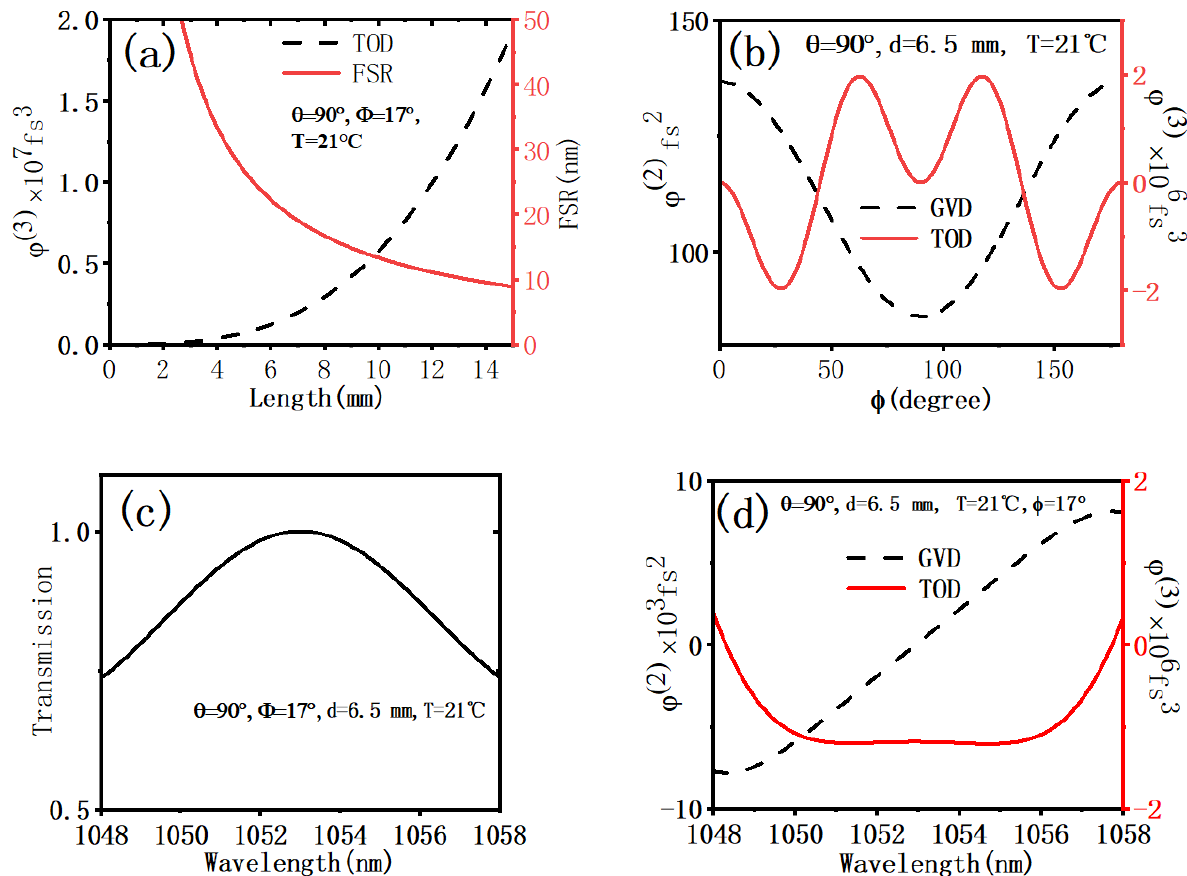
Figure 6. ( a ) Maximum amplitude of TOD and FSR changing with the length of the birefringent plate; ( b ) The GVD and TOD change with φ , in which the length of the plate is 6.5 mm; ( c ) The transmission curve for TOD compensation; ( d ) The GVD and TOD curves changing with wavelength for the TOD compensation parameters.